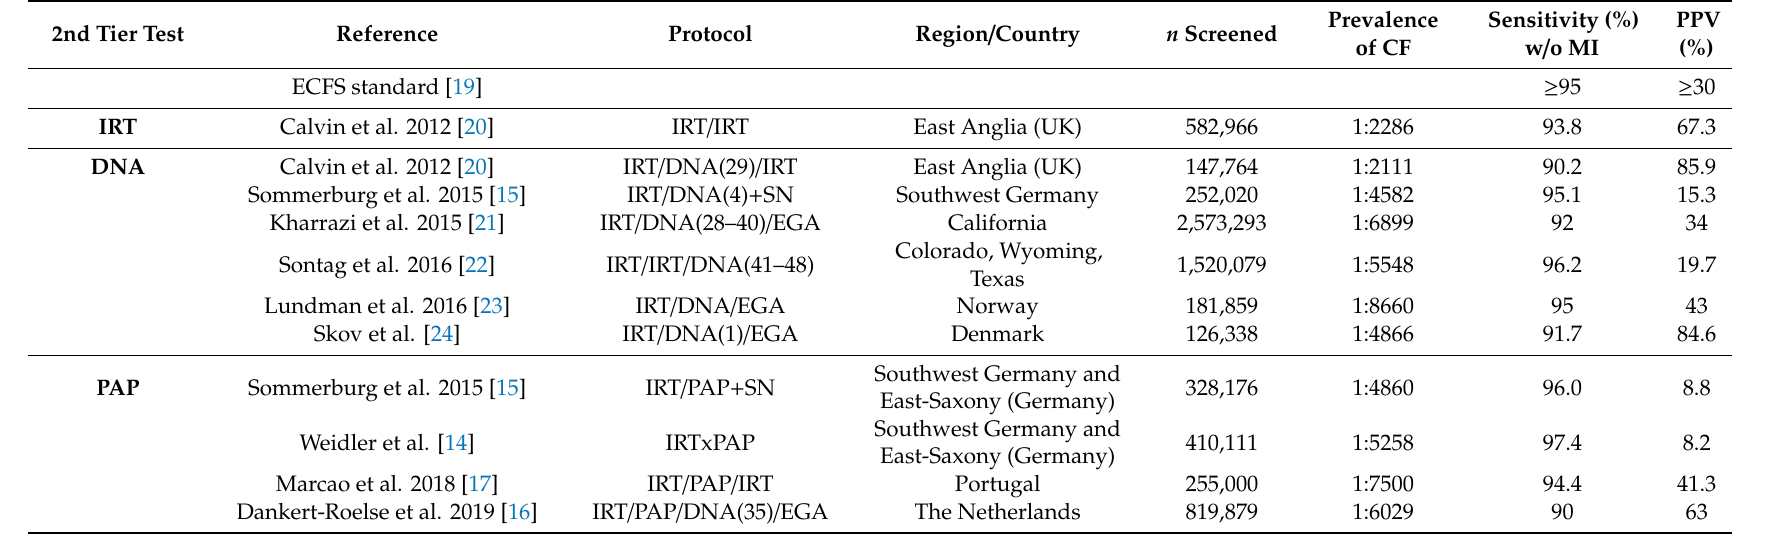
Table 1. Performance indicators sensitivity (%), positive predictive value (PPV, (%)) and CF / CFSPID ratio of a number of representative genetic and PAP-based CF-NBS protocols of di ff erent countries and regions compared to the ECFS standard. The numbers in parentheses within the protocol name reflect the CFTR mutations in the panel